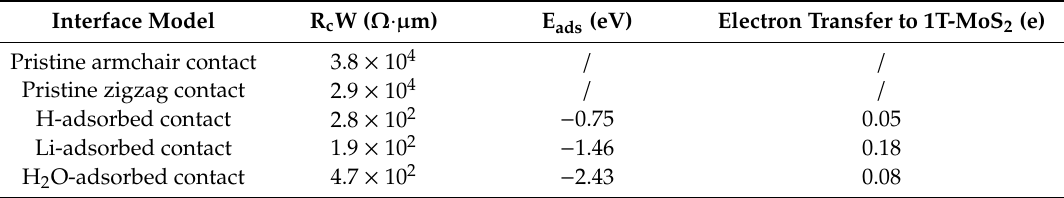
Table 2. Computed contact resistance, adsorption energies E ads and electron transfer (Hirshfeld population analysis) of the di ff erent 1T / 2H-MoS 2 interface models. The adsorption energies and